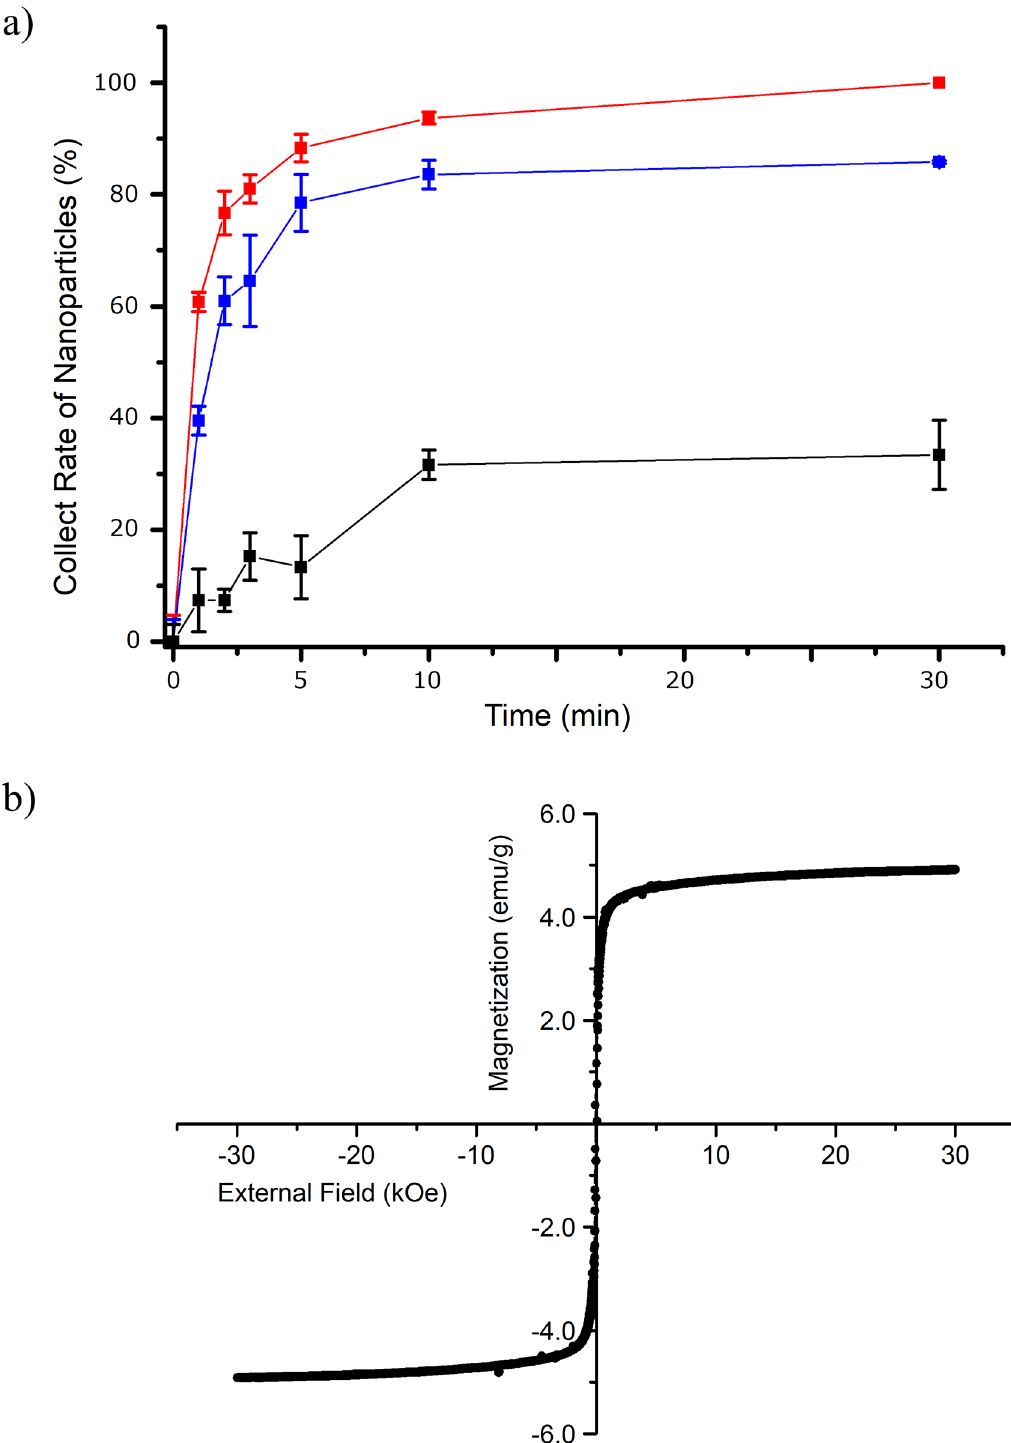
Fig 3. Magnetic properties of the prepared magnetic NPs. a) Accumulation profiles for the DL MNPs (red), SL MNPs (blue), and the silica-coated Fe 3 O 4 NPs (black). b) Hysteresis loop of the DL MNPs.